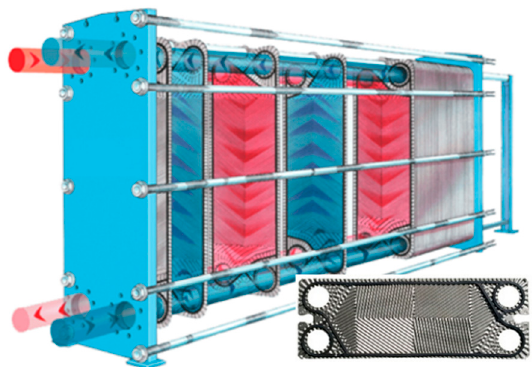
Figure 18. Plate heat exchanger and example of plate pattern (source: Grano Heat Energy Technology Co. Ltd. https://www.grano-heat.com).